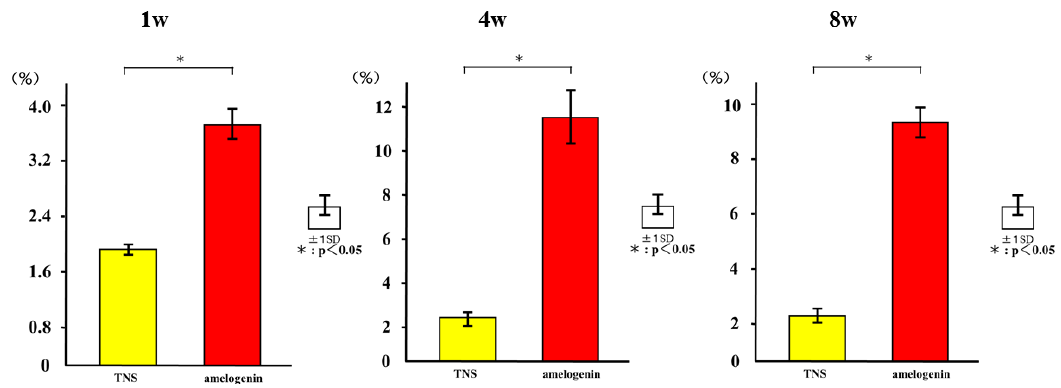
Figure 17. The percentage of labeled bone area (%LBA). * p < 0.05.